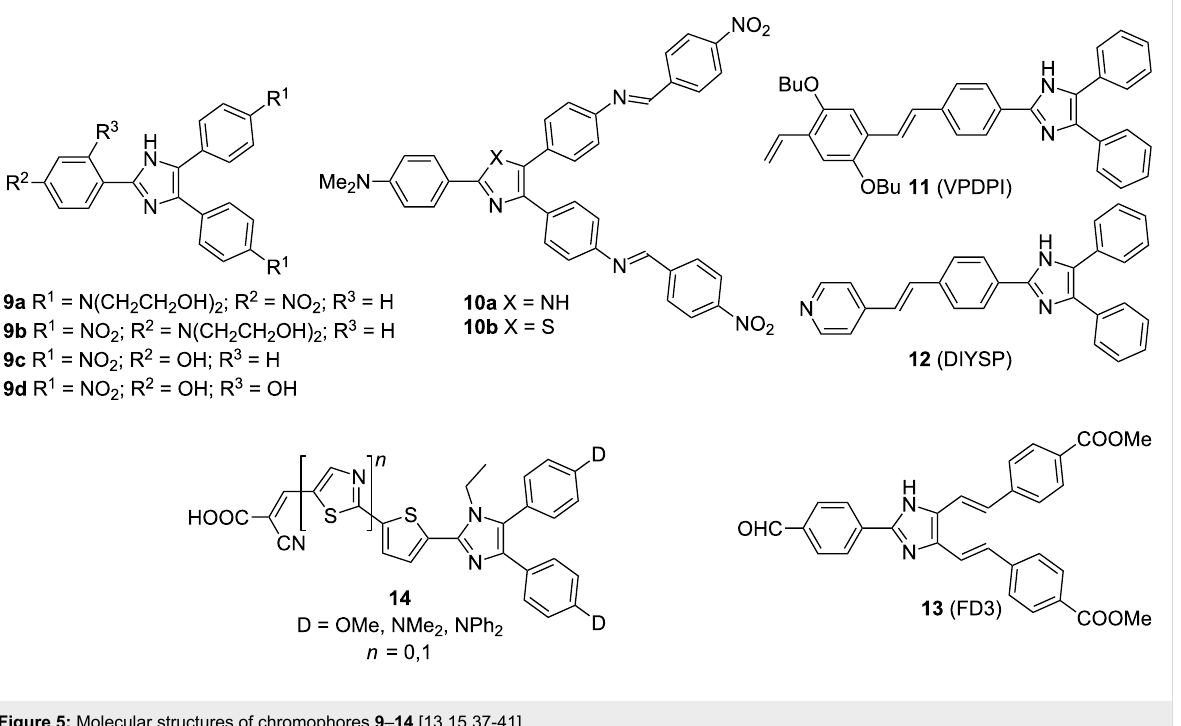
Figure 5: Molecular structures of chromophores 9 – 14 [13,15,37-41].